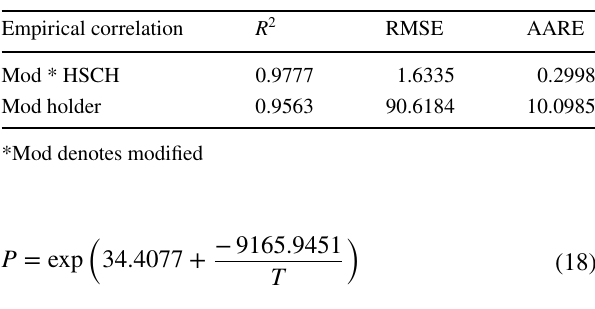
Table 10 Statistical error of HFP using modified empirical correla- tions